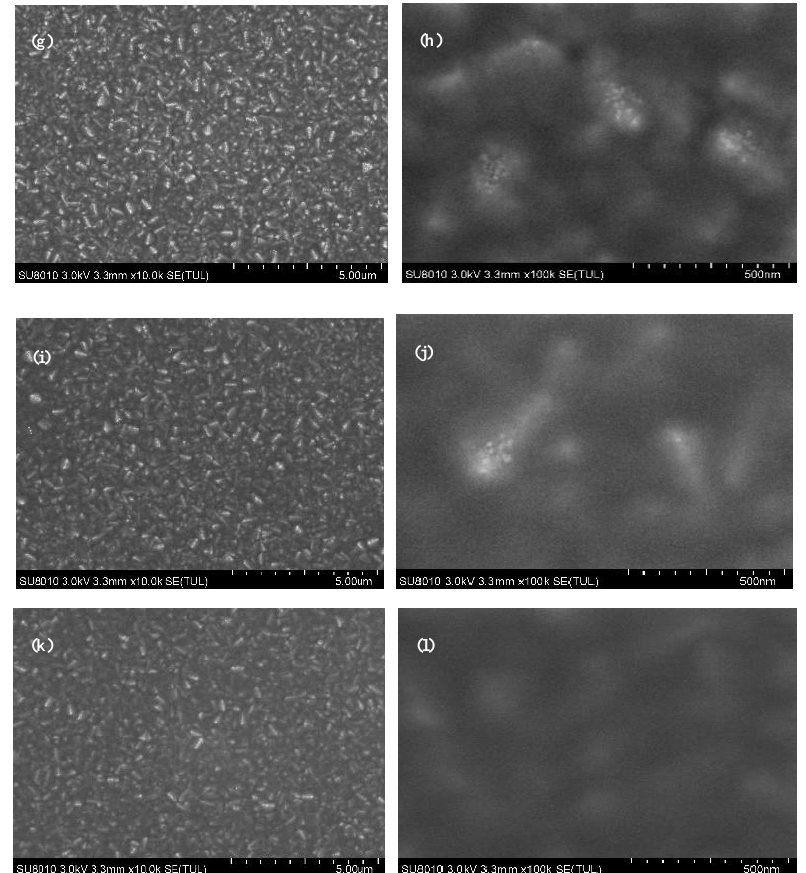
Figure 4. SEM images of nano TiO 2 layer under Process 2: ( a , c , e , g , I , k ) Represent 0, 5, 10, 15, 20, 25 mg/mL, respectively, the low magnification; ( b , d , f , h , j , l ) The corresponding high magnification. The meaning of Process 2 is described in the third paragraph of experimental Section 2.2.2.